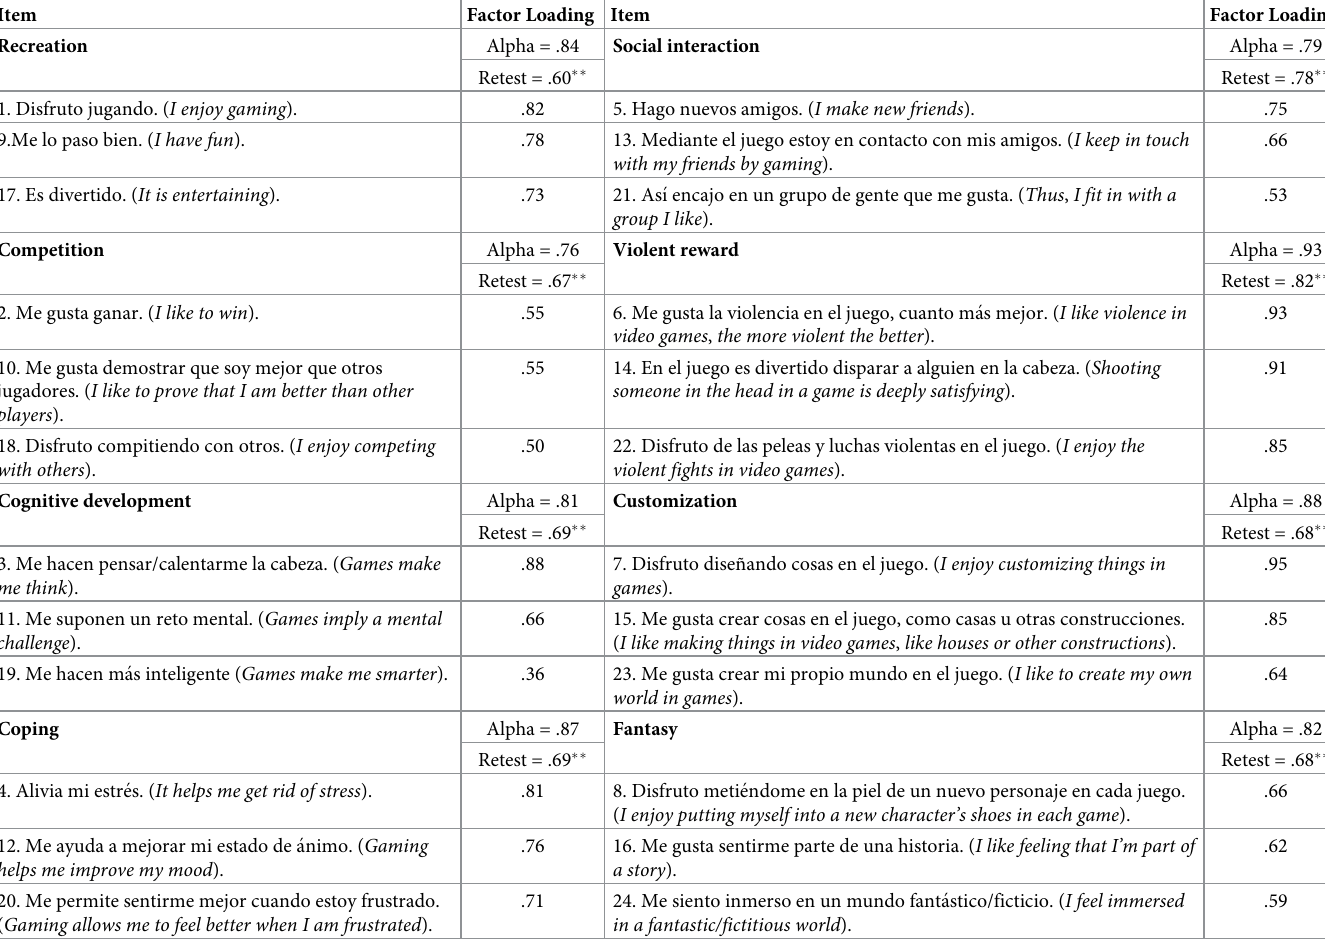
Table 2. Exploratory factor analysis and reliability of the